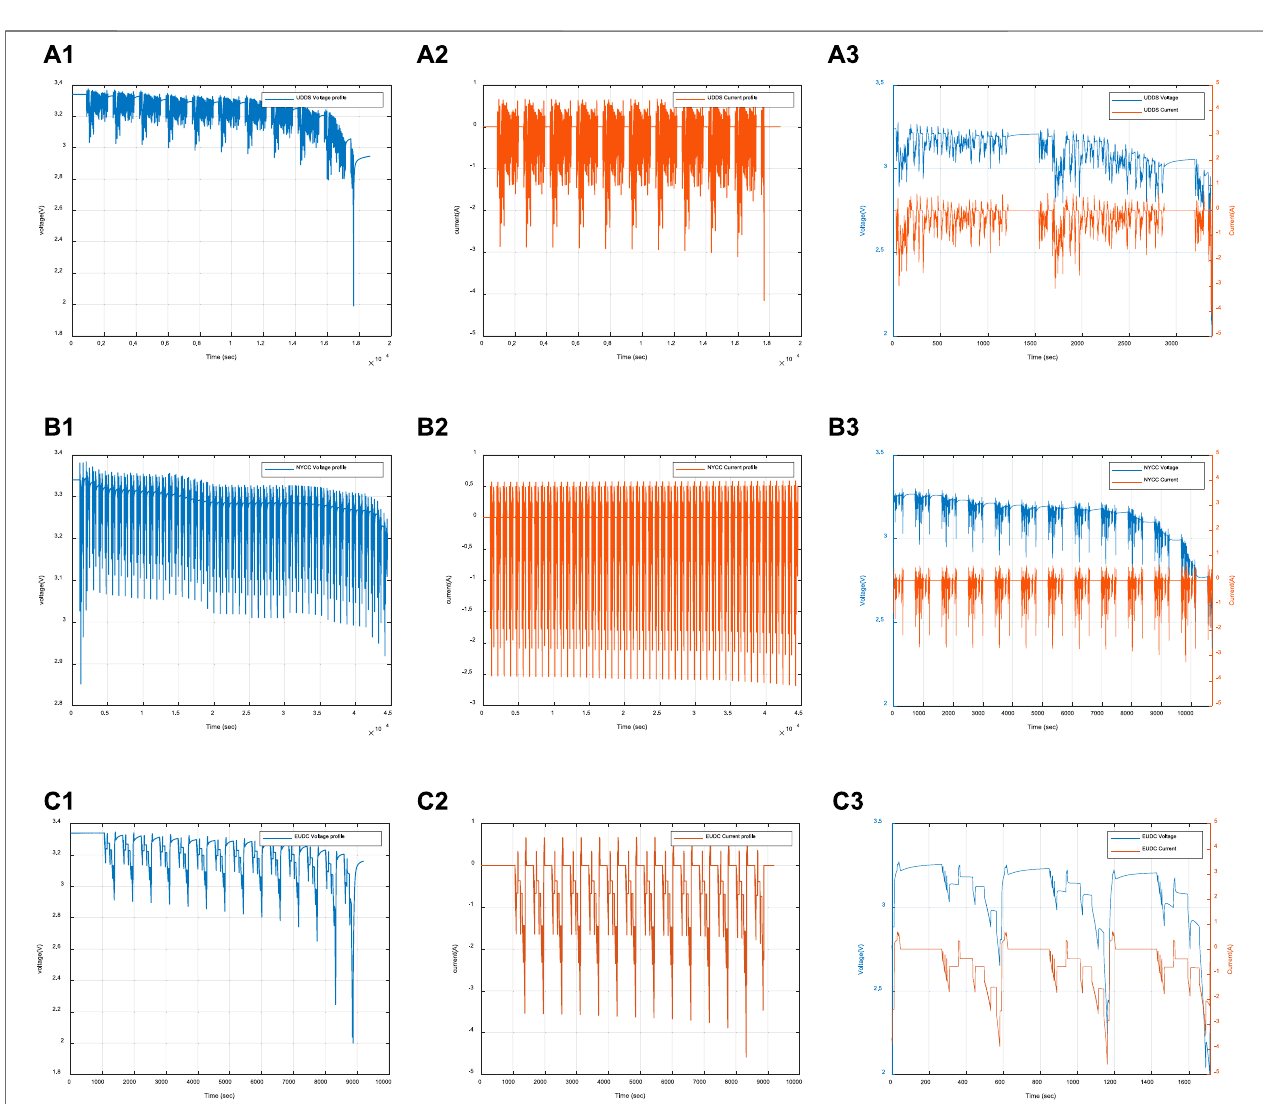
FIGURE 2 | Three driving cycles ’ voltage and current undercharging and discharge operations.